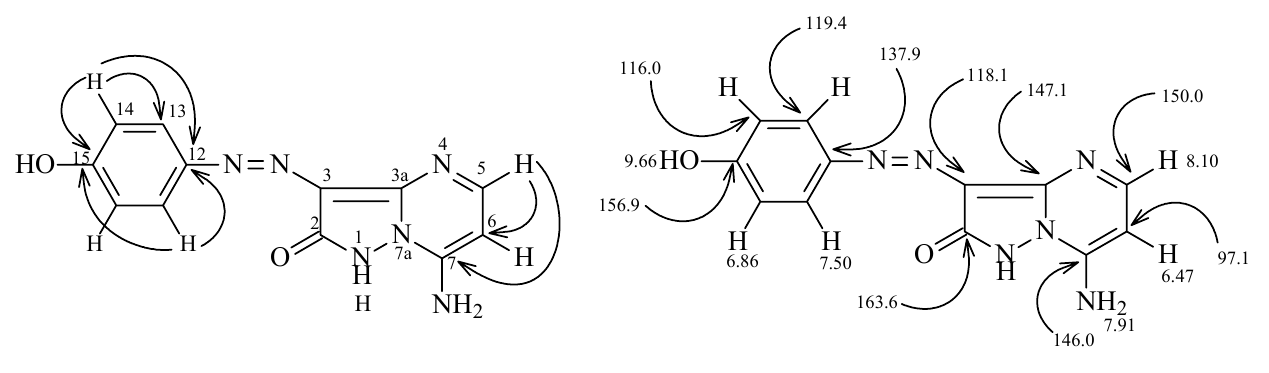
Figure 2. 1 H and 13 C NMR spectroscopy assignments of compound 10